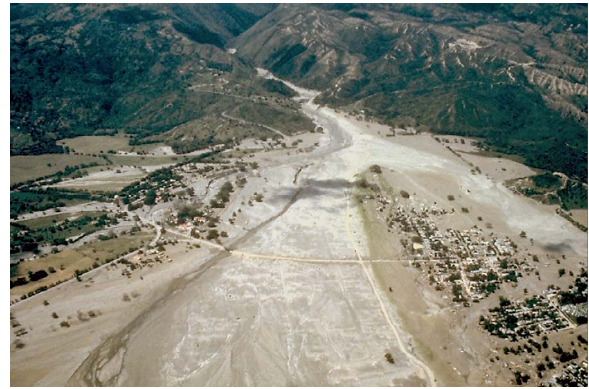
Fig. 10. Aerial oblique view of what remains of the city of Armero, Colombia, after it was devastated by destructive lahars generated by the 13 November 1985 eruption at Nevado del Ruiz (see text). These lahars swept down the steep valley of the Río Lagunillas (upper center of picture). [Photograph by Richard Janda, USGS.]